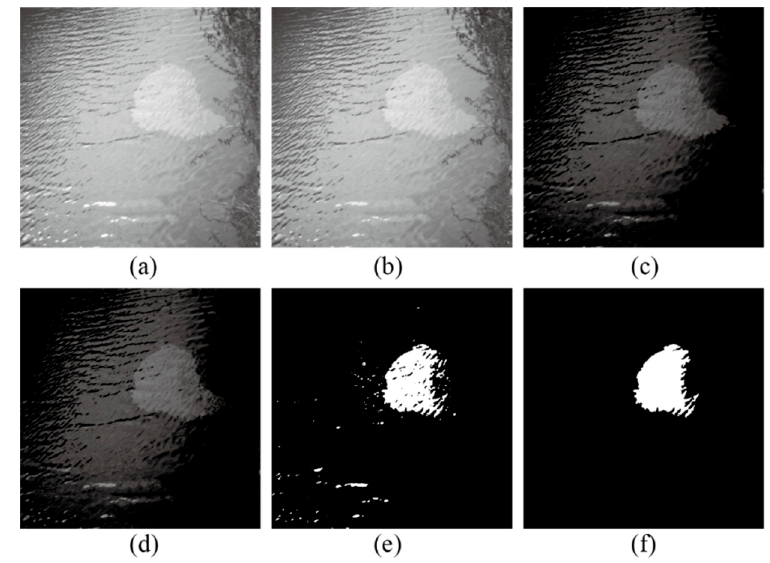
Figure 11 . Segmentation result of a target uneven illumination. ( a ) The original image; ( b ) the preprocessed image; ( c ) the result using GBS; ( d ) the result using ATE; ( e ) the segmentation result with LFTM; and ( f ) the final segmentation result.